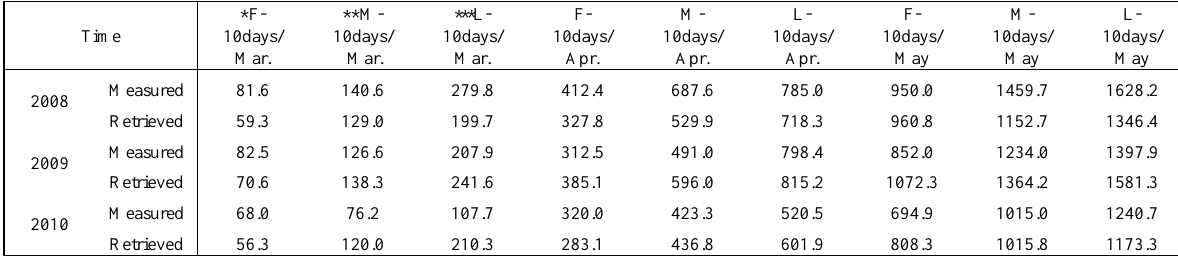
Table 2. The comparison of AGB in situ observation and retrieved from remote sensing in 2008-2010a